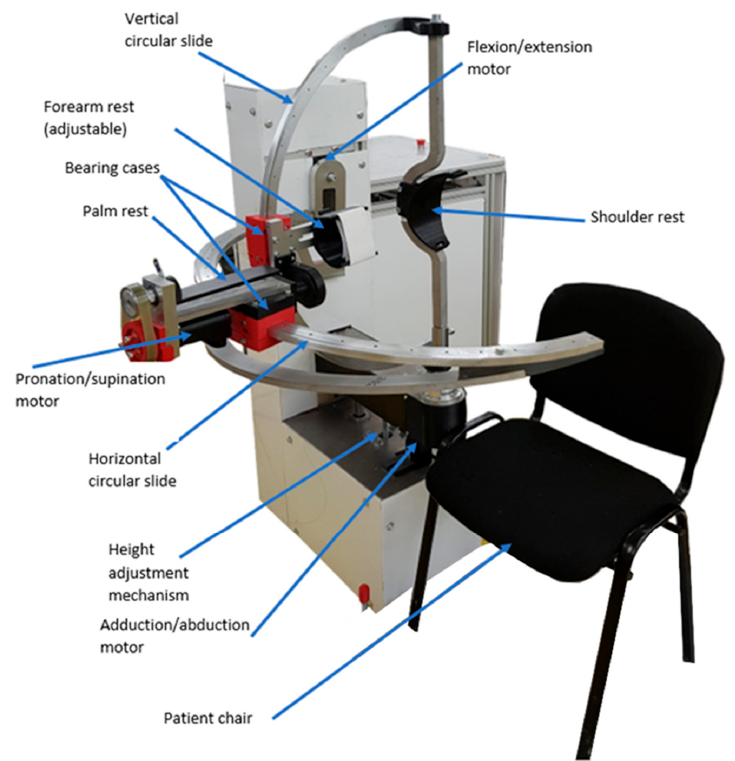
Figure 15. Optimized structure after the clinicians’ feedback and clinical